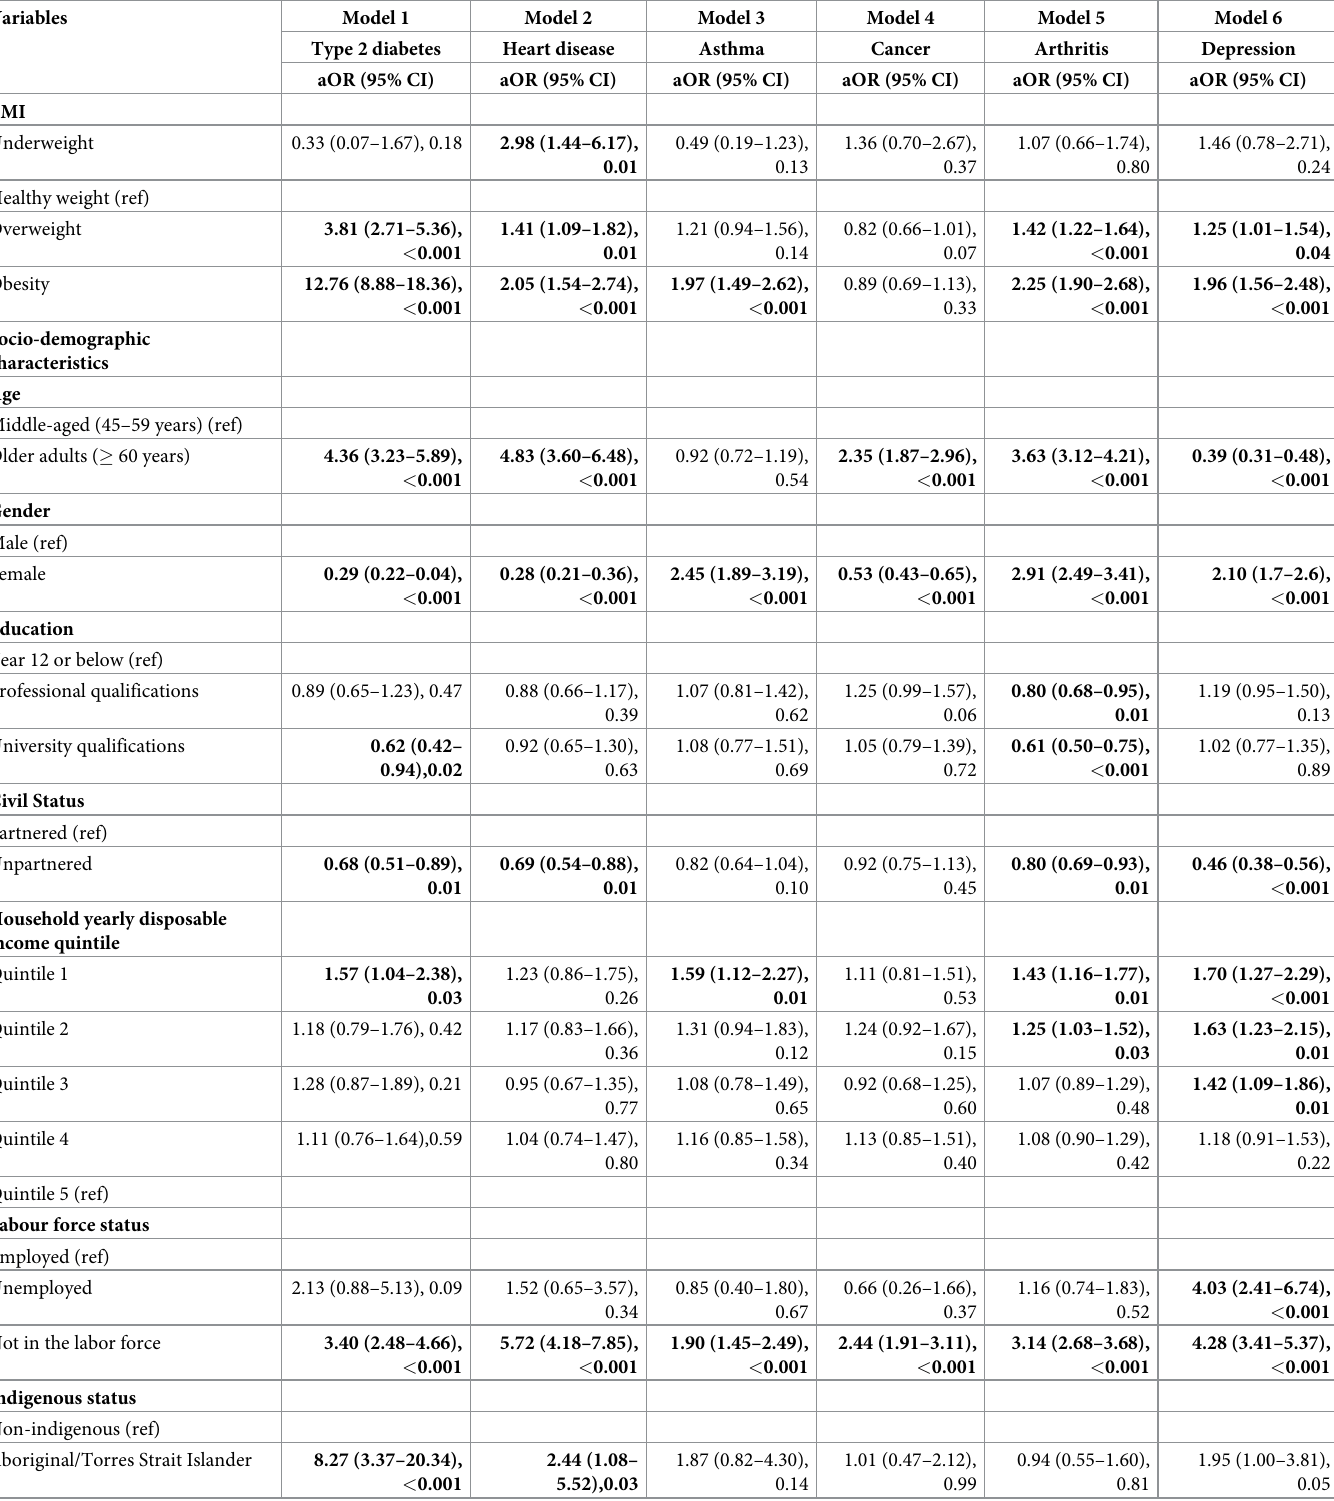
Table 3. Adjusted random-effect regression results for the between-person differences in chronic conditions due to obesity; 9,822 persons, 20,538